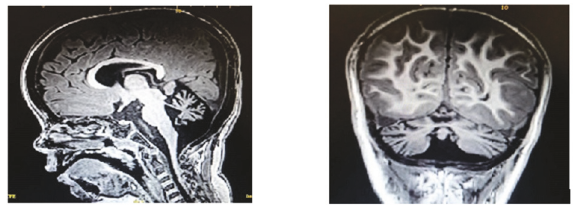
Figure 2: T1-weighed brain MRI of the index patient showing cerebellar